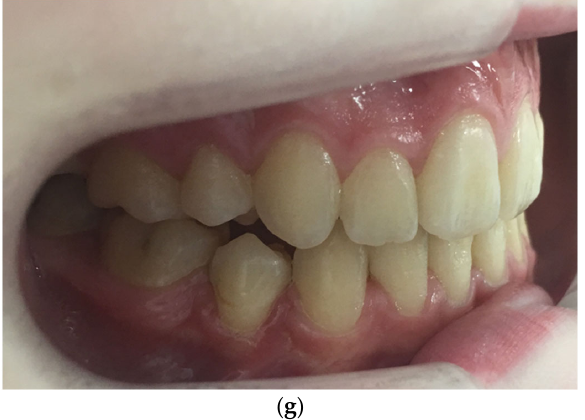
Figure 1. ( a – g ) The preoperative panoramic radiograph following the removal of the four first premolars, showing impacted and distally angulated mandibular second premolars ( a ) and the pre-operative views of the surgical exposure site ( b , c ), one week after diode laser exposure (940 nm). Bonding with simultaneous traction using power chain, absence of inflammation or swelling one week post-op ( d ), subsequent re-bonding with premolar brackets, and final result are shown ( e – g ).